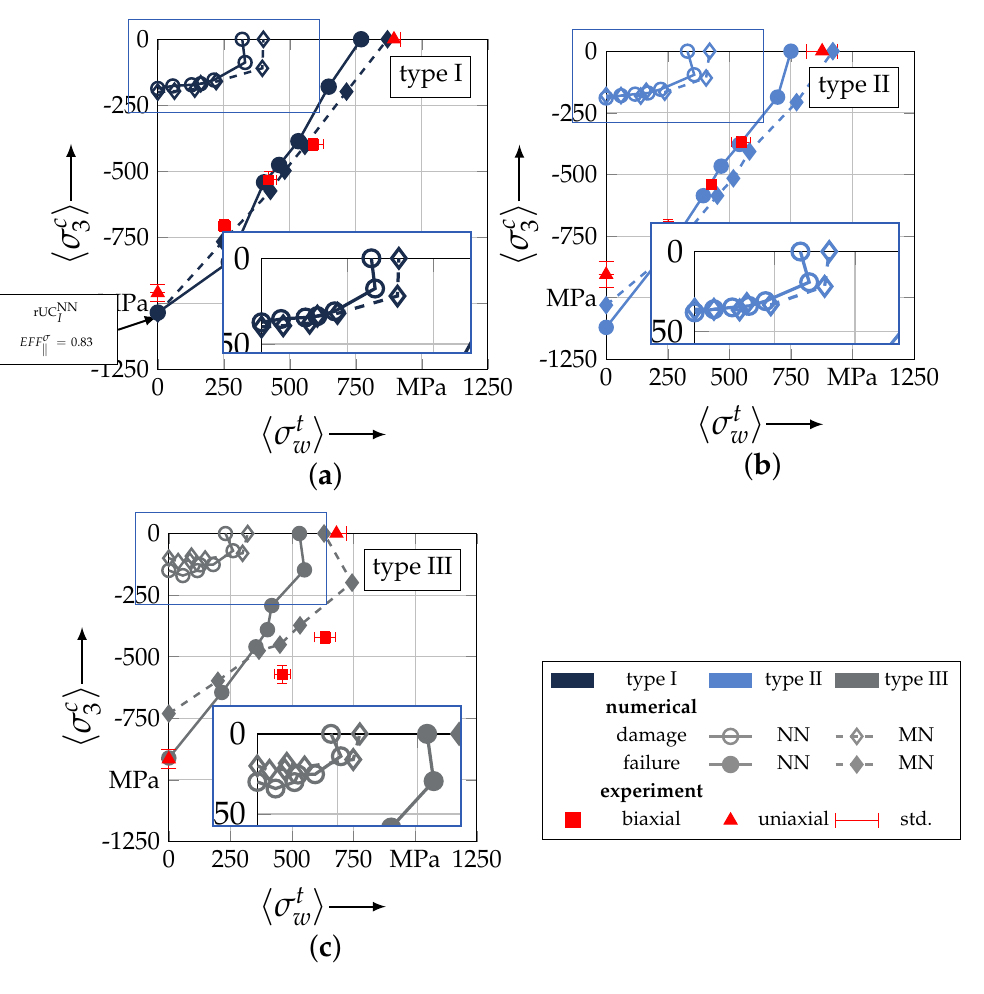
Figure 21. Comparison of experimentally and numerically determined fracture resistances for ( a ) type I, ( b ) type II and ( c ) type III